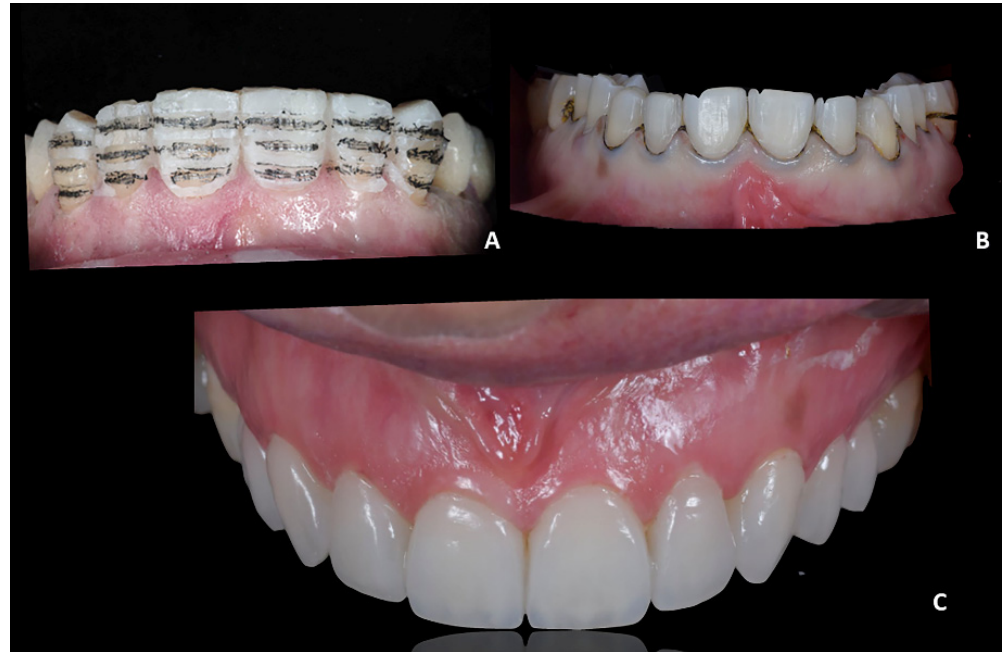
Figure 6. Case 1. ( A ) The mock-up served as reference guide to define the thicknesses of the prosthetic preparation; ( B ) teeth preparation; ( C ) final ceramic veneers and aesthetic rehabilitation.